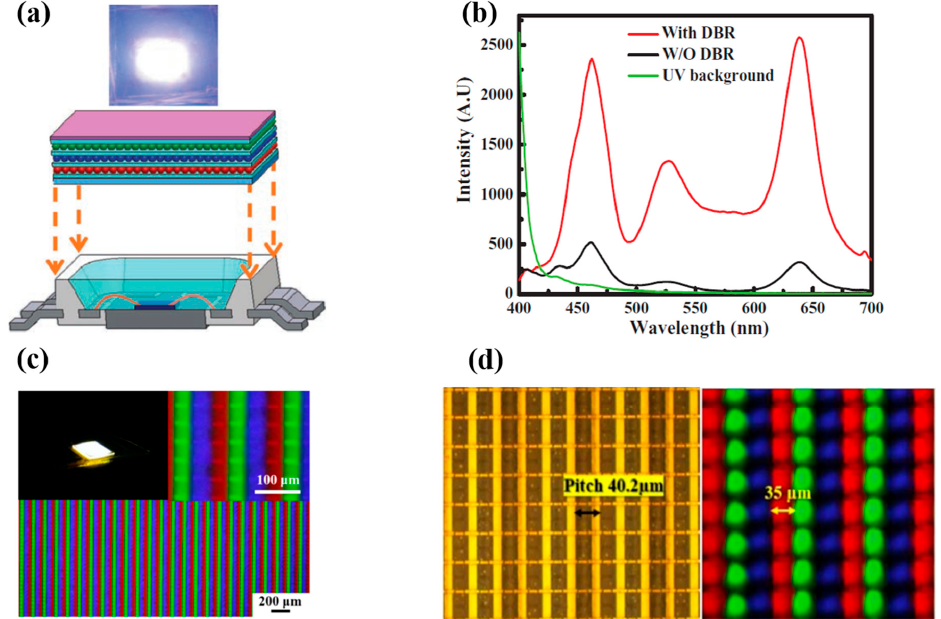
Figure 1. ( a ) Schematic of QD-LED device (bottom). Photograph of the QD-LED during operation (top). ( b ) EL spectra with and without the DBR structure. ( c ) Image of sprayed QDs µLED array under fluorescence microscopy at different magnifications. ( d ) Top-view image of the µLED layout with pitch of 40.2 µm defined as the intended channel (left). Quantum dots (QD) droplets jetted in the PR mold to confine the size and resolve the cross-talk effect (right) [44]. Figure reproduced with permission from John Wiley and Sons.